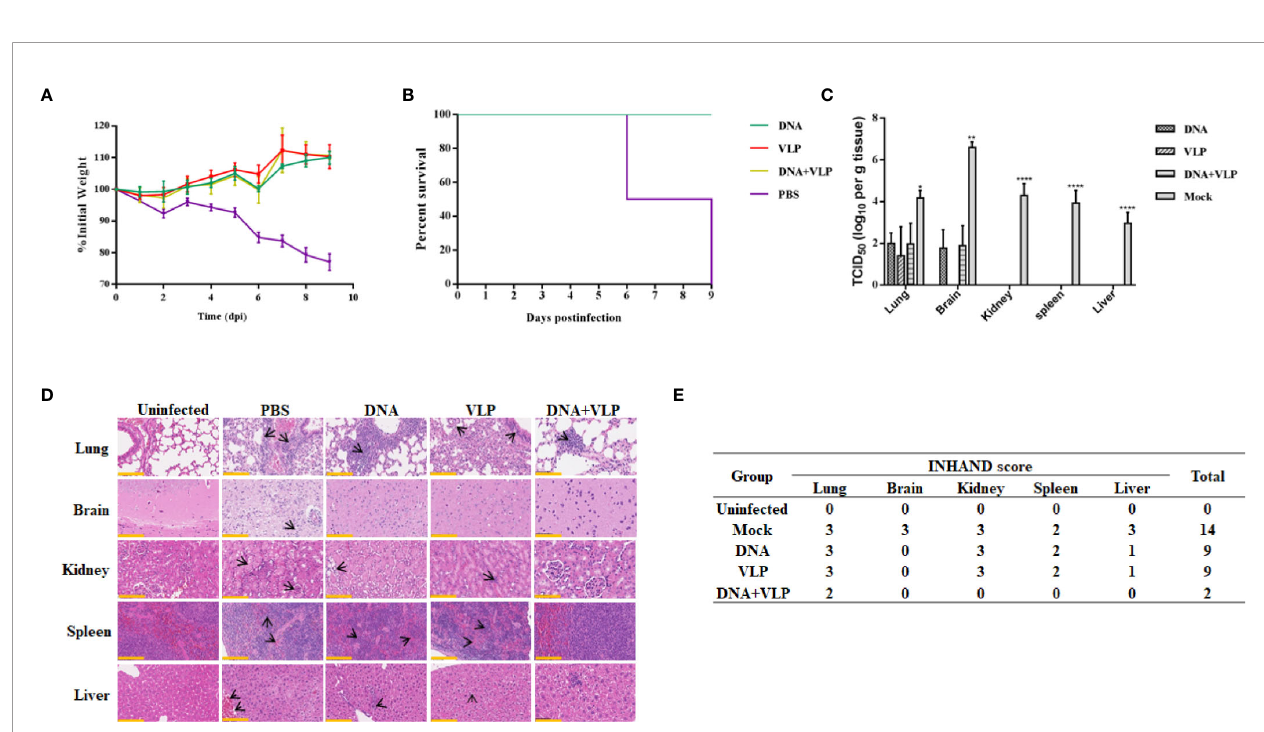
FIGURE 6 | Co-immunization protects mice from lethal CHIKV challenge. Mice infected with 1.7×10 7 TCID 50 of the CHIKV Ross were monitored daily for body weight (A) and survival (mean ± standard error [SEM], n=6) (B) . Mice (n=3) sacri fi ced at day 9 post challenge. The heart, liver, spleen, lung, kidney, brain, and hind limbs of mice were harvested after sacri fi ced. Tissue supernatants were analyzed for viral load by real-time qRT-PCR. Data represent three independent experiments and are shown as the mean ± standard error [SEM]. The statistical analysis among groups analyzed by two-way ANOVA, ****p<0.0001, **p<0.01, *p<0.05. None viral load detected in heart and hind limbs of each group (C) . Histopathological analysis of tissues at day 9 after challenge. Section of different tissues were stained with hematoxylin and eosin. Scale bar, 100 m m. The black arrowhead stood for lesions in tissue (D) (3 mice per group and 1 section per tissue). INHAND scores of challenged mice organs, on a severity scale of 0 – 3 (none, mild, moderate, and severe) (E)